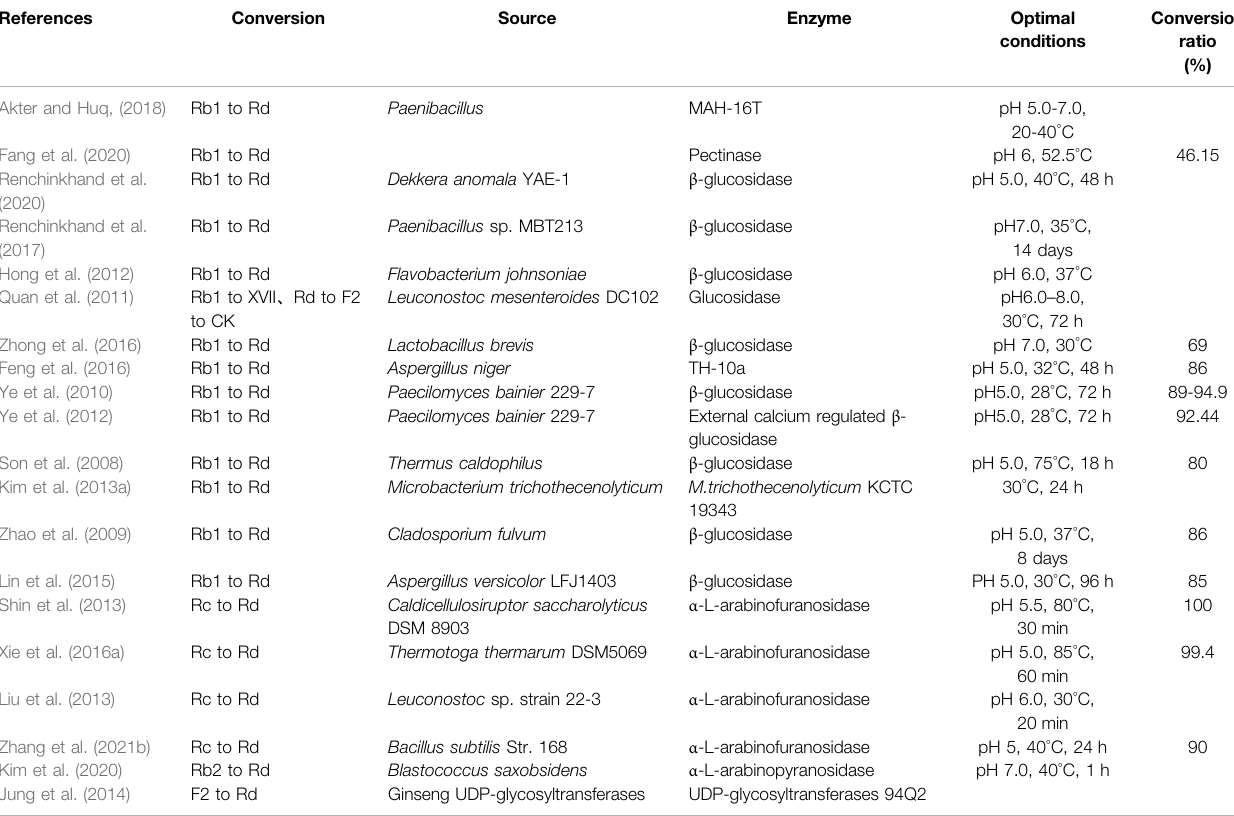
TABLE 1 | Summary of the biotransformation of ginsenoside